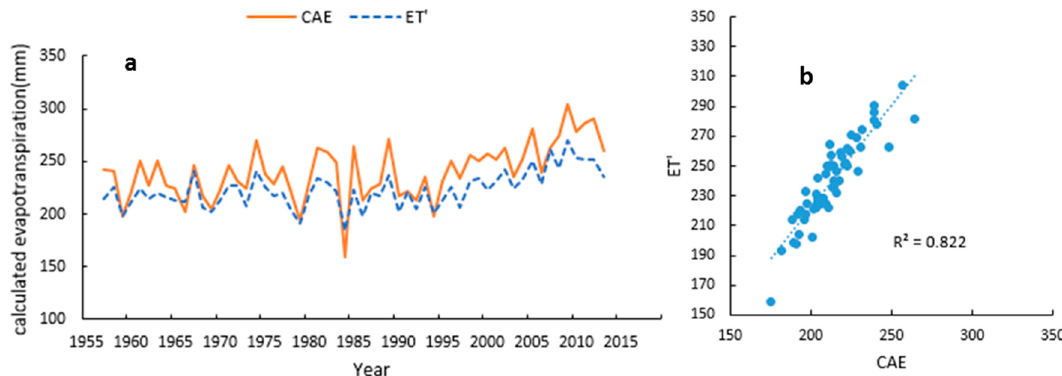
Figure 4. Correlation between CAE (Takahashi) and ET ′ (L ‐ T); ( a ) time series of calculated annual evapotranspiration (CAE as solid line, ET ′ as dashed line) in mm; ( b ) cross correlation between CAE and ET ′ . Water 2017 , 9 , 115